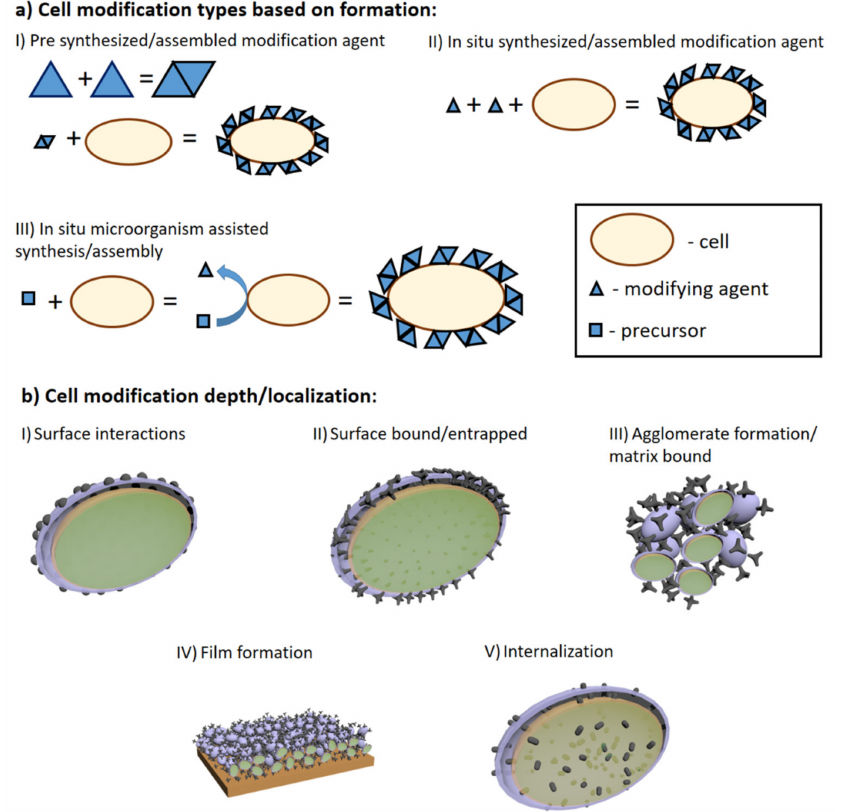
Figure 6. ( a ) Schematic representation of cell modification by agent formation principle. Cells can by modified using pre-synthesized compounds (I), assembled/ synthesized in situ with living cells are present (II) and in situ when cell assists/catalyzes synthesis assembly of modification agent; ( b ) schematic representation of modifying agent localization in MFC applications: (I) surface interactions as adsorption, electrostatic interactions etc.; (II) modifying agent is either covalently bonded or forms interlacing and inseparable structures with cell walls or other similar structures; (III) when modifying agent forms aggregates from its matrix and cells; (IV) higher agglomerate organization onto surfaces; (V) internalization of modification